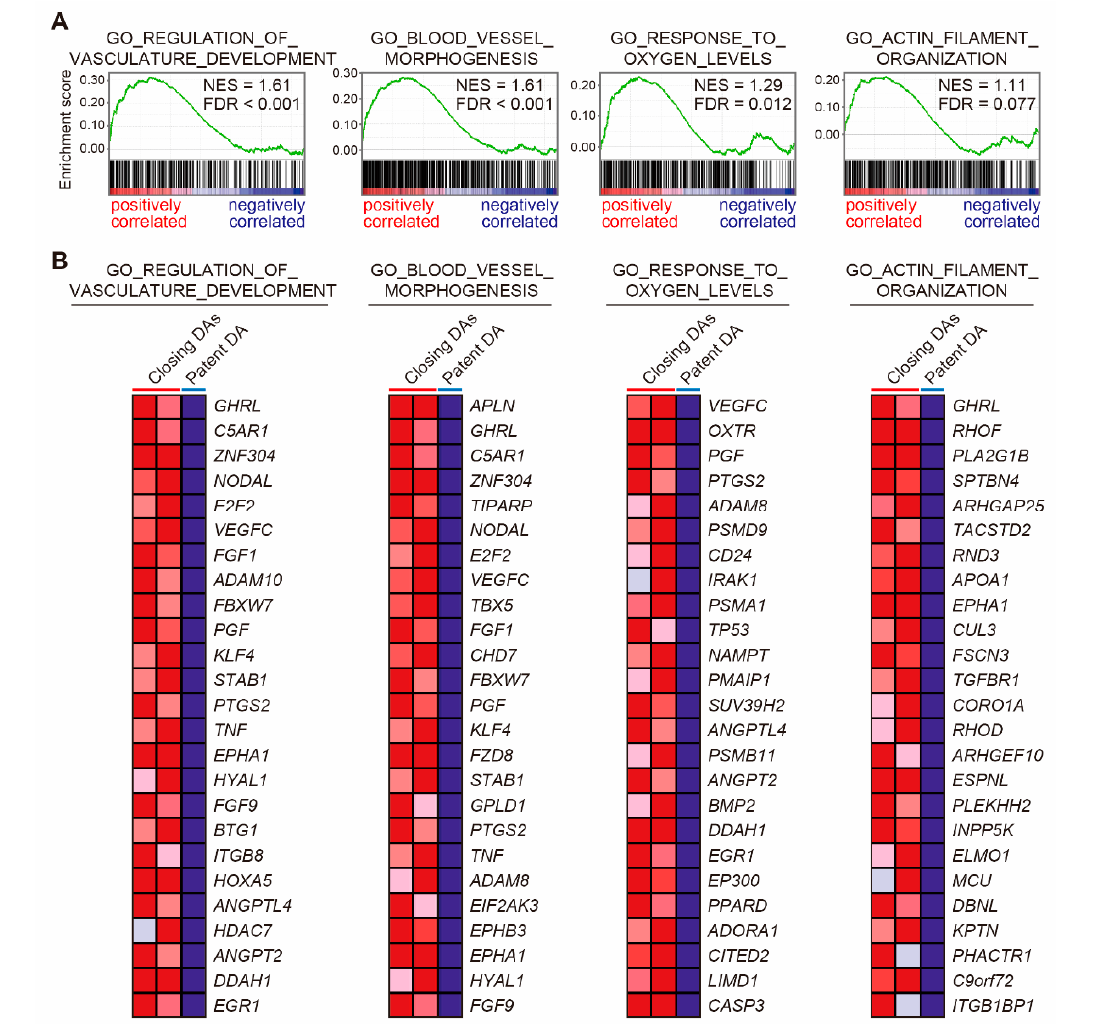
Figure 3. Gene set enrichment analyses (GSEAs) of the tunica media of the closing human ductus arteriosus (DA) and the patent DA tissues. ( A ) GSEAs revealed positive correlations between the tunica media of the closing human DA tissues and vascular development–related genes, oxygen level response-related genes, and actin filament organization-related genes. On the x -axis, the genes in each gene set are ranked from the left side (positively correlated) to the right side (negatively correlated). The vertical black lines that look like barcodes indicate each gene in the gene set. The y -axis displays the calculated enrichment score of each gene (green color). NES, normalized enrichment score; FDR, false discovery rate. ( B ) The top 25 genes that comprise the leading edge of the enrichment score in ( A ) are shown in each heatmap.